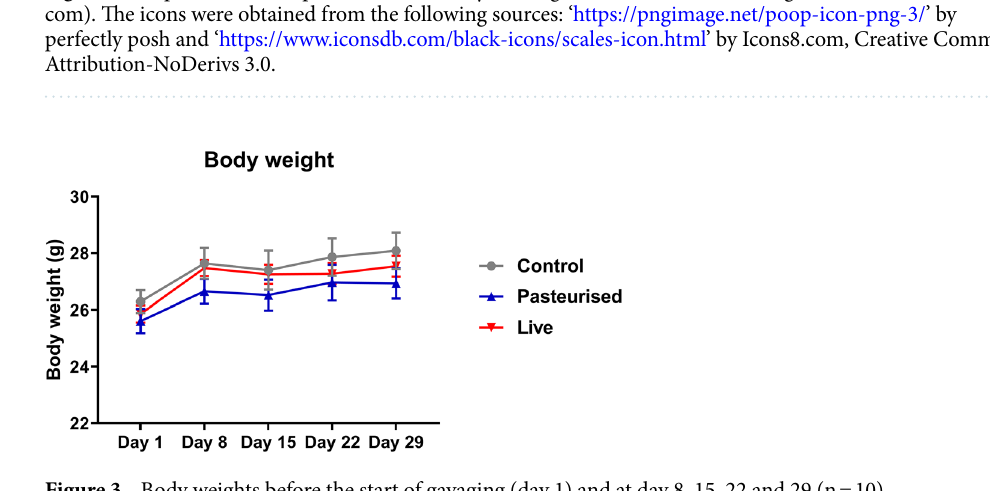
Figure 3. Body weights before the start of gavaging (day 1) and at day 8, 15, 22 and 29 (n =